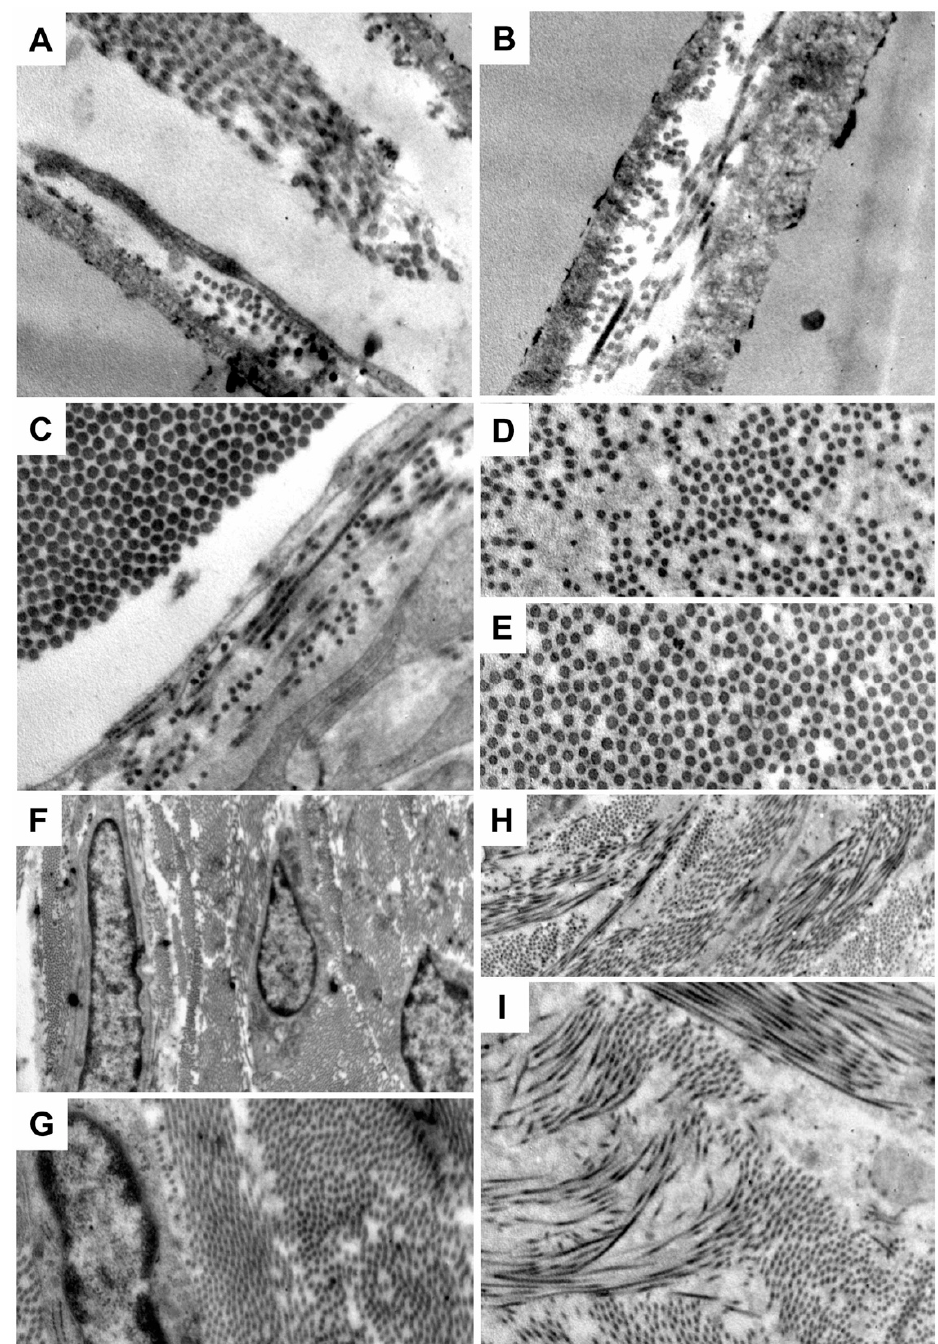
Figure 6. Electron microscopy analysis. ( A ) Normal undamaged tendon. ( B – E ) Hyaloglide ® group. ( F – H ) Control untreated group. Magnification: ( A , B ) = 50,000×; ( C – E ) = 60,000×; ( F ) = 10,000×; ( G ) = ( F – H ) Control untreated group. Magnification: ( A , B ) = 50,000X; ( C – E ) = 60,000X; ( F ) = 10,000X; 30,000×; ( H ) = 15,000×; ( I ) = 25,000×. ( G ) = 30,000X; ( H ) = 15,000X; ( I ) =